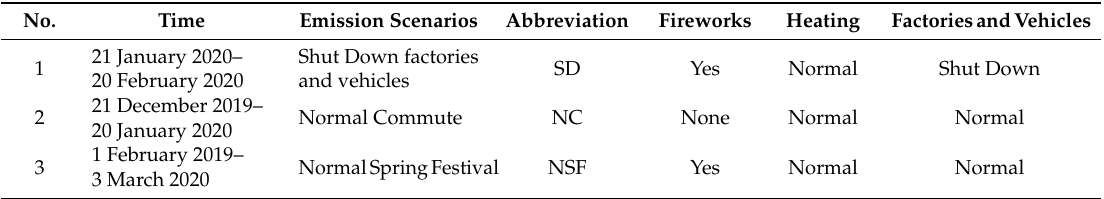
Table 1. Emission scenarios of the study